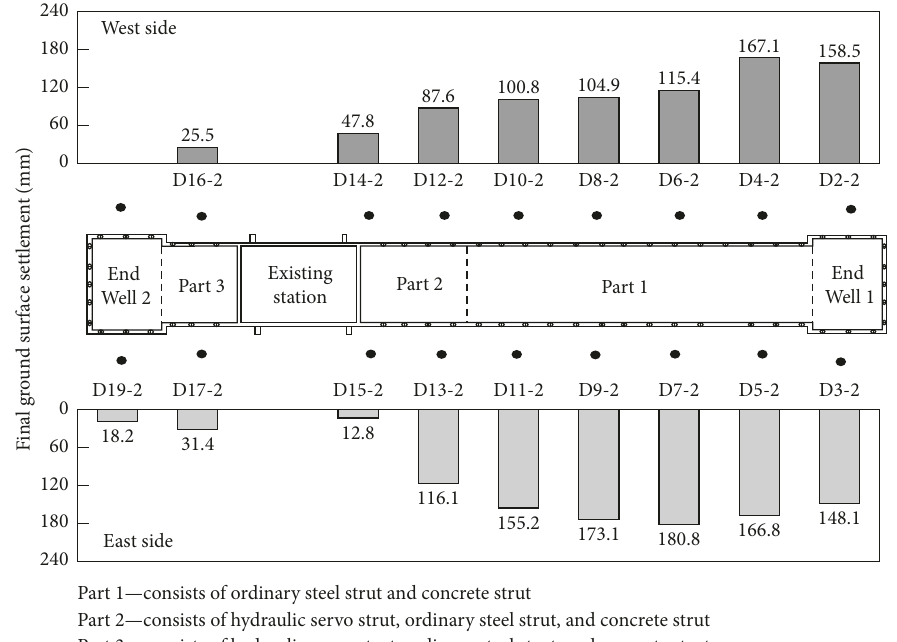
Figure 15: Final surface settlement at 10m along the edge of the foundation